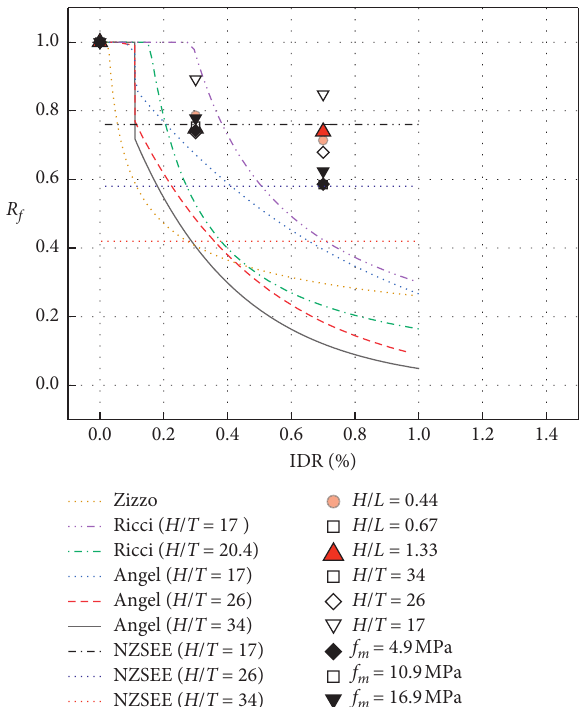
Figure 16: Comparison of the strength reduction factor of infill